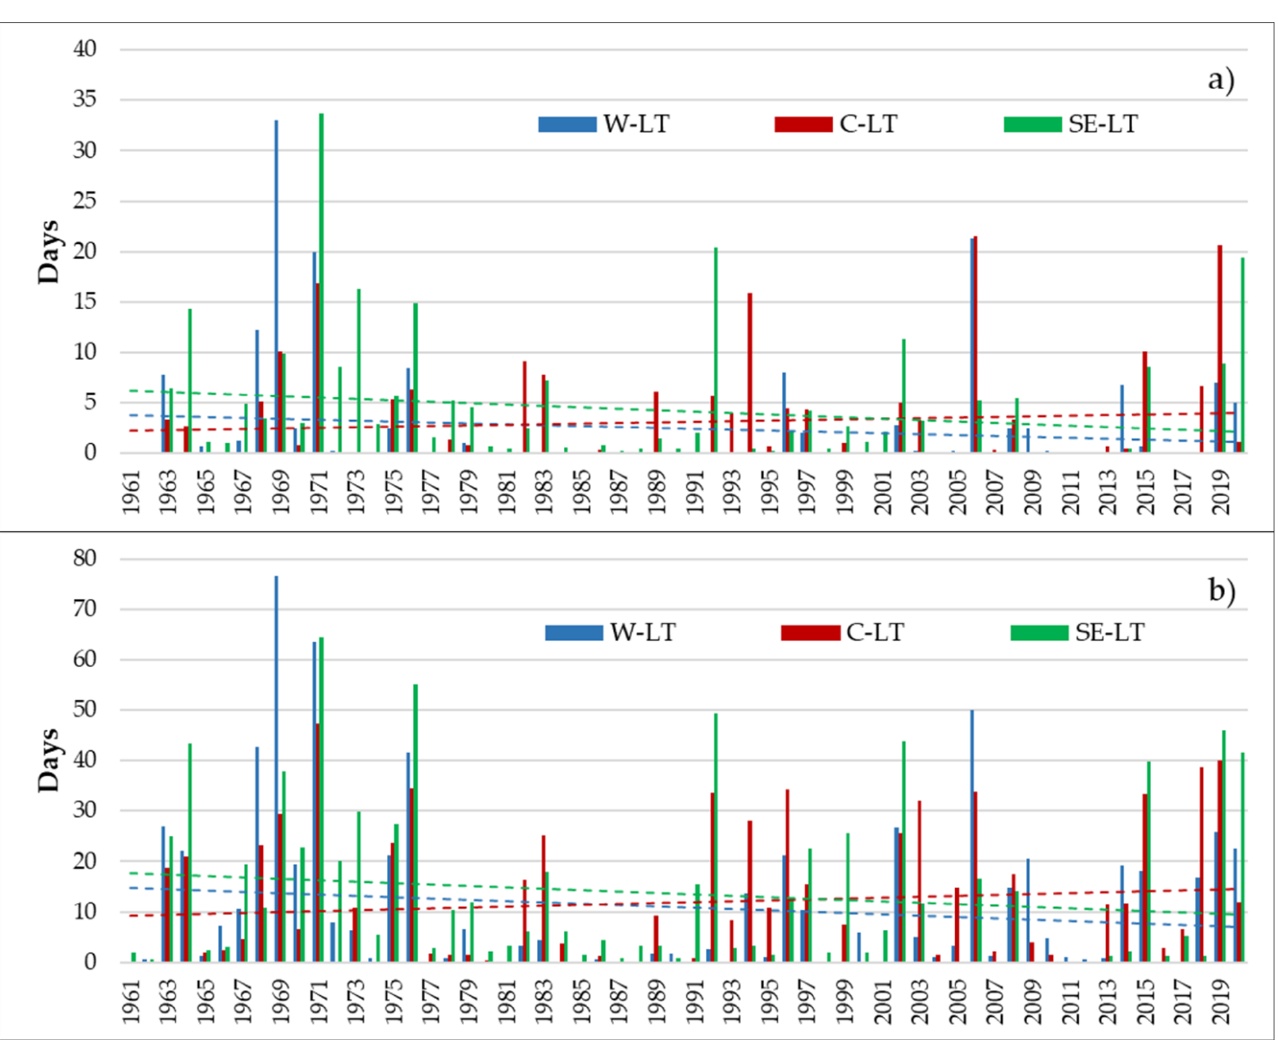
Figure 10. The average number of drought days in the three regions: ( a ) at threshold 30Q95, ( b ) at threshold 30Q80 .